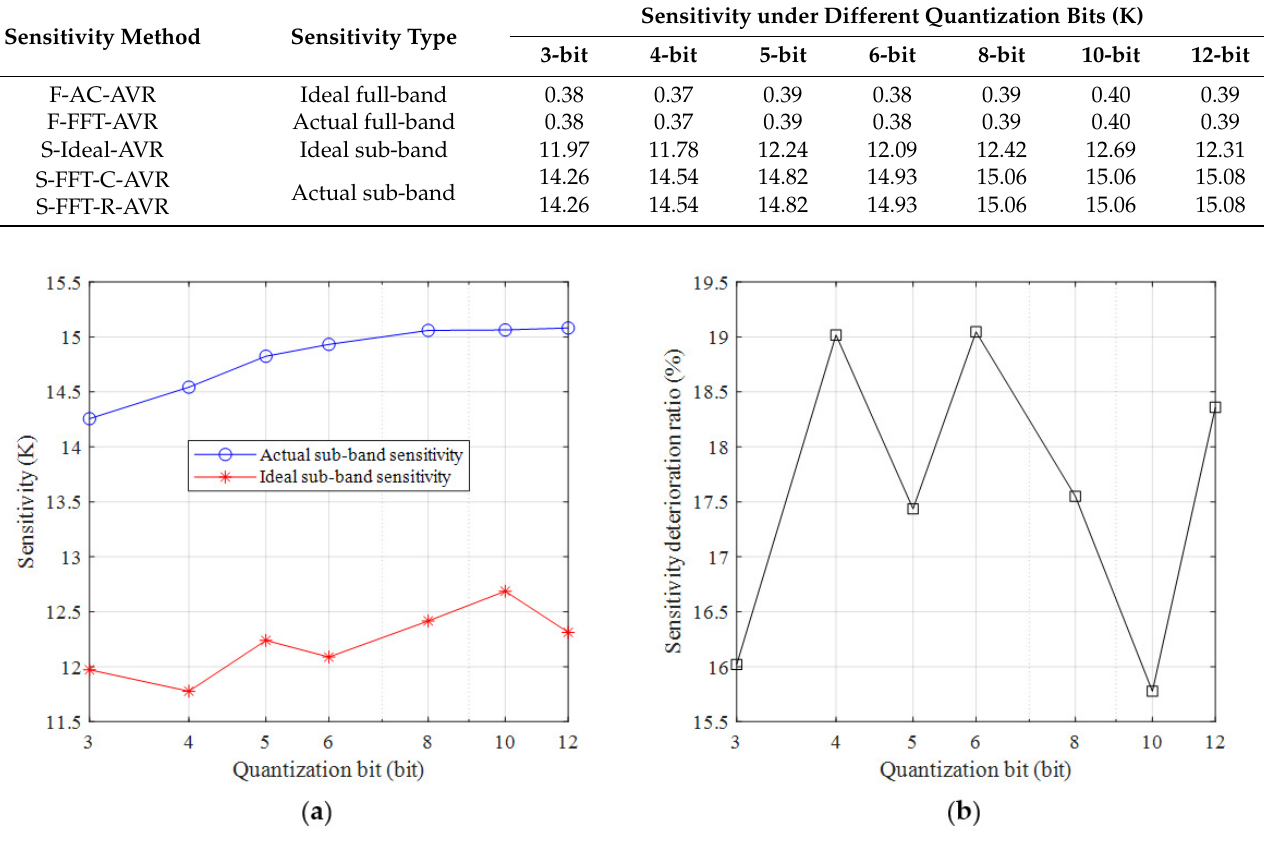
Figure 14. The sub-band sensitivity comparison and deterioration obtained by different quantization bits: ( a ) actual sub-band sensitivity and ideal sub-band sensitivity; ( b ) sub-band sensitivity deterioration